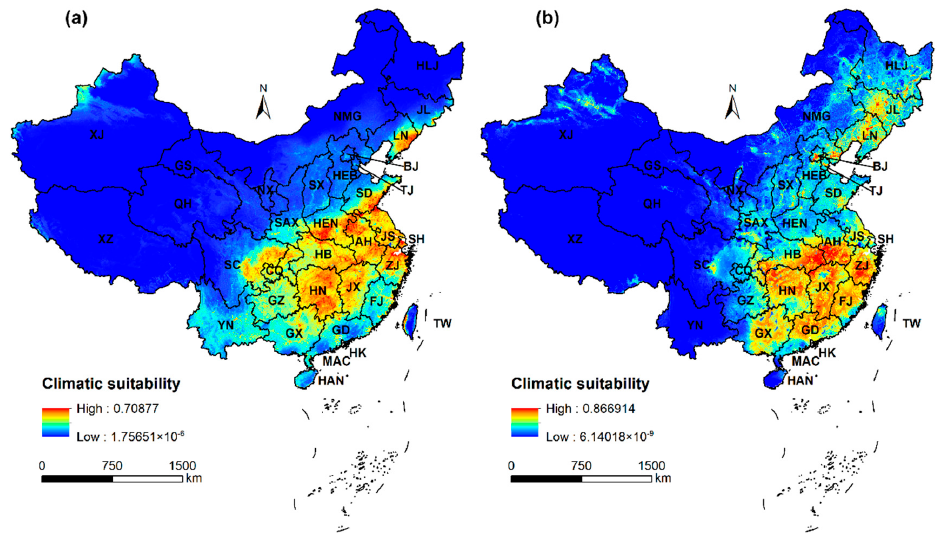
Figure 3. Prediction of the potential distribution of Ambrosia artemisiifolia in China based on occur- rences from ( a ) native range (Native) and ( b ) China (Inv-China). Province abbreviations: AH = Anhui, BJ = Beijing, CQ = Chongqing, FJ = Fujian, GD = Guangdong, GS = Gansu, GX = Guangxi, GZ = Guizhou, HEN = Henan, HB = Hubei, HEB = Hebei, HAN = Hainan, HK = Hong Kong, HLJ = Heilongjiang, HN = Hunan, JL = Jilin, JS = Jiangsu, JX = Jiangxi, LN = Liaoning, MAC = Macau, NMG = Inner Mongolia, NX = Ningxia, QH = Qinghai, SC = Sichuan, SD = Shandong, SH = Shanghai, SAX = Shaanxi, SX = Shanxi, TJ = Tianjin, TW = Taiwan, XJ = Xinjiang, XZ = Tibet, YN = Yunnan, ZJ = Zhejiang.